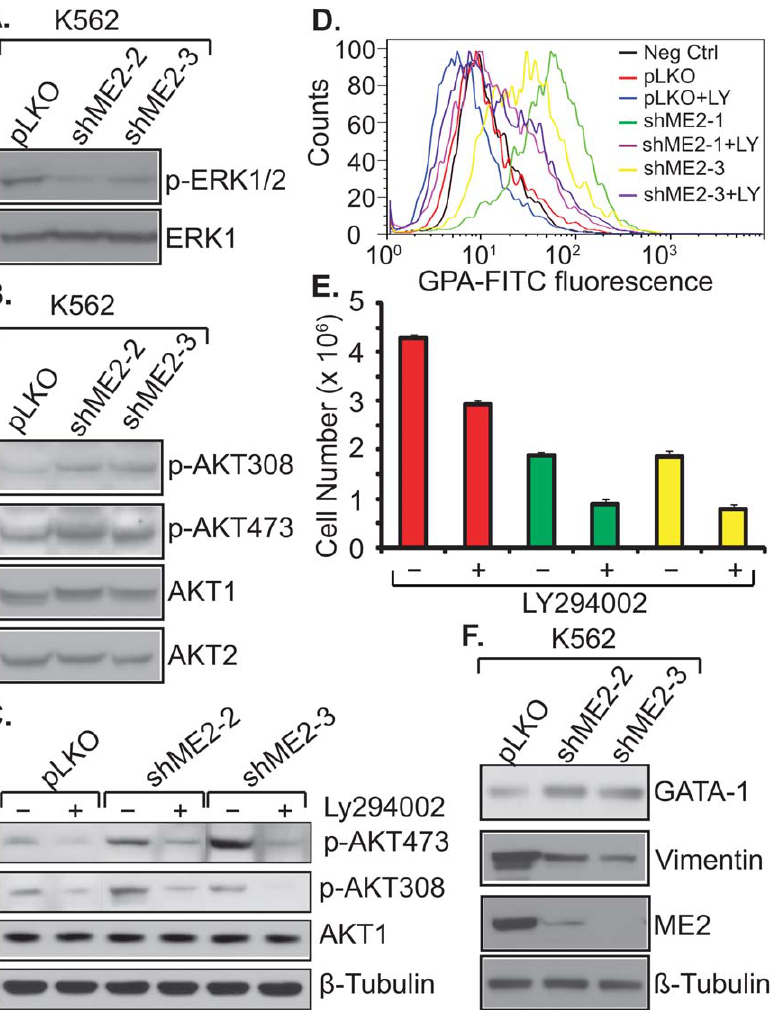
Figure 7. Effects of ME2 knockdown on signaling pathways, and GATA-1 and vimentin expression. K562 cells with or without ME2 knockdown were lysed with RIPA lysis buffer (50 mM Tris-HCl, pH 8.0, 150 mM NaCl, 1% Triton X-100, 1 mM EGTA) containing 1 mM PMSF and a protease inhibitor cocktail and subjected to centrifugation at 15,000 6 g for 10 min at 4 u C to remove debris. After lysis, equal aliquots of protein lysate were resolved by Western blotting. Western blots were probed with anti-phospho-ERK1/2, anti-ERK1, anti-p-AKT308, anti-AKT472, anti-AKT1/2, anti- GATA-1, anti-vimentin and anti- b -tubulin. A, phospho-ERK1/2 activity in ME2 knockdown K562 cells. B, Phospho-AKT detection in ME2 knockdown K562 cells. C, 10 m M PI3K inhibitor, LY294002, inhibits p-AKT activity. D, LY294002 rescue of differentiation in ME2 knockdown K562 cells. E, The effect of LY294002 on the proliferation of K562 cells with or without ME2 knockdown. F, The expression difference of GATA-1 and vimentin in ME2 knockdown cells. Data are representative of three independent